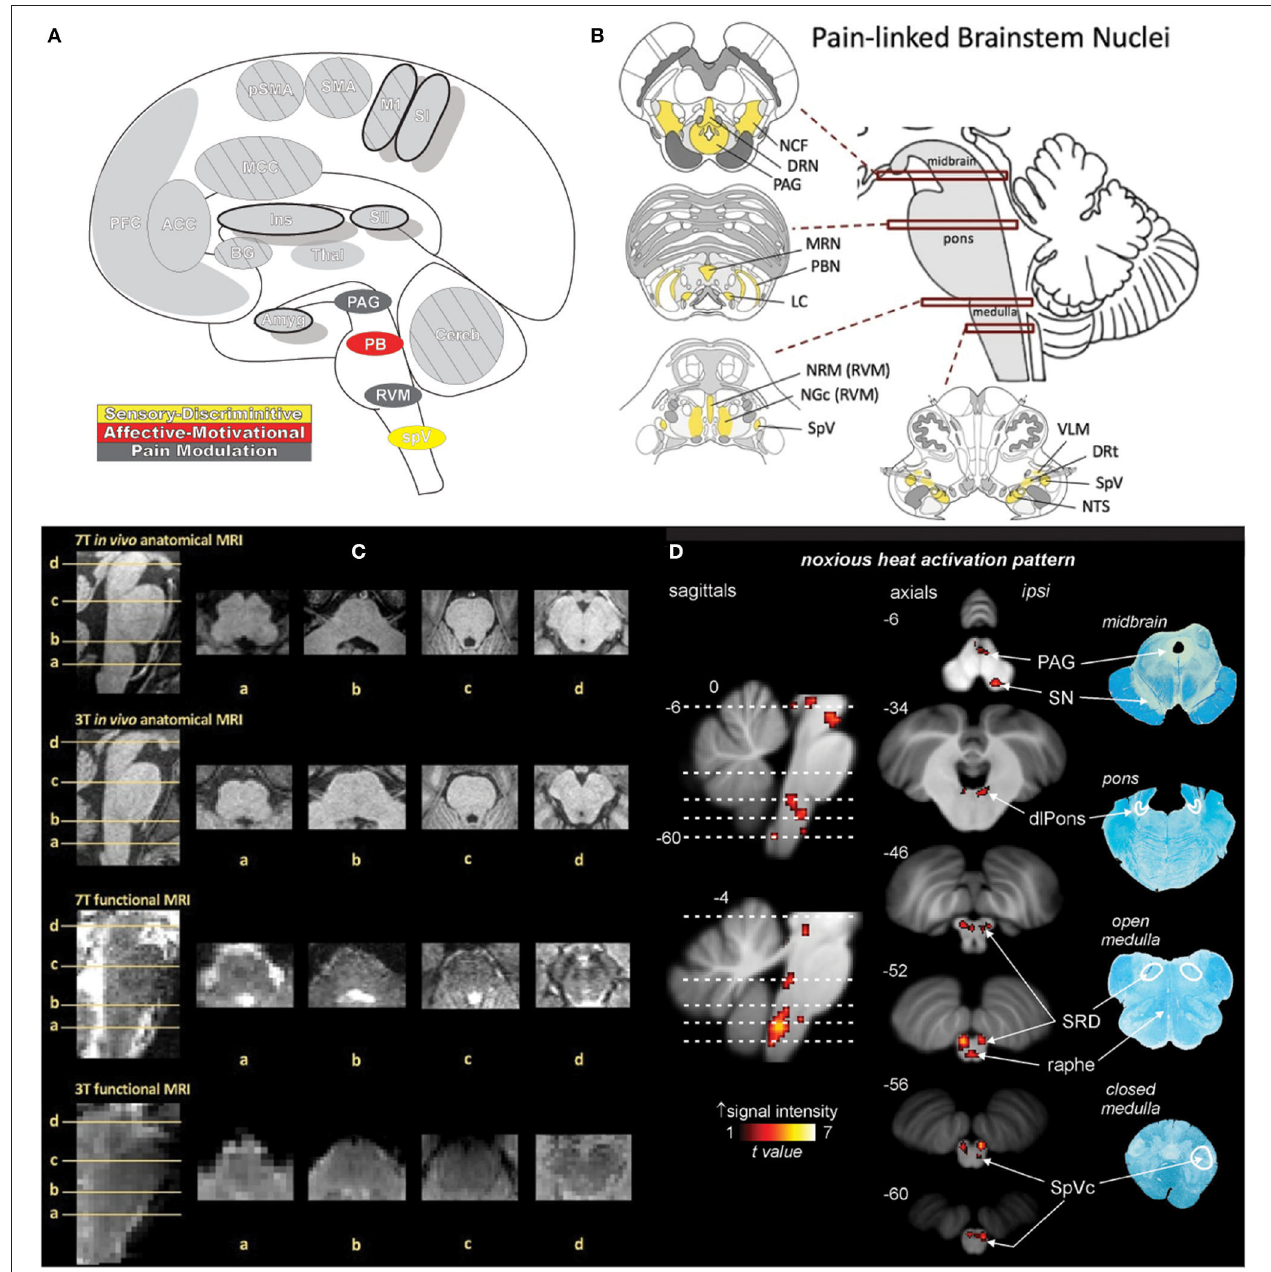
FIGURE 12 | Brainstem. (A) Brain areas active during pain: periaqueductal gray (PAG), parabrachial nuclei (PB), rostral ventromedial medulla (RVM), spinal trigeminal nucleus (SpV) highlighted. (B) Schematic of brainstem nuclei associated with pain processing. Reprinted from PAIN Reports, Vol 4(4), V Napadow, R Sclocco, LA Henderson, Brainstem neuroimaging of nociception and pain circuitries, p e745, Copyright (2019) Napadow et al., under the Creative Commons Attribution License (CC-BY). DOI: https://dx.doi.org/10.1097%2FPR9.0000000000000745. (C) Axial slices containing brainstem nuclei from Figure. 12(B) arranged to compare the spatial resolution and quality of anatomical and functional MRI data at different magnetic field strengths (7 Tesla and 3 Tesla). Advances in imaging techniques and technologies promise to advance neuroimaging investigation of the brainstem as subtle differences in increasingly fine and detailed structures can be appreciated by MRI. Reprinted from PAIN Reports, Vol 4(4), V Napadow, R Sclocco, LA Henderson, Brainstem neuroimaging of nociception and pain circuitries, p e745, Copyright (2019) Napadow et al., under the Creative Commons Attribution License (CC-BY). DOI: https://dx.doi.org/10.1097%2FPR9.0000000000000745. (D) fMRI activations in the medulla, pons, and midbrain in response to brief noxious thermal stimulation, comprising activation of ascending nociceptive pathways and descending pain modulation, highlighting the dense and complex pain circuitry present in the brainstem. Myelin-stained ex-vivo axial sections are displayed to the right of corresponding sagittal and axial MRI slices. Reprinted from NeuroImage, Vol 124(Part A), AM Youssef, VG Macefield, LA Henderson, Pain inhibits pain; human brainstem mechanisms, p54-62, Copyright (2020), with permission from Elsevier. DOI: https://doi.org/10.1016/j.neuroimage.2015.08.060. DRN, dorsal raphe nucleus; DRt, dorsal reticular nucleus; LC, locus coeruleus; MRN, median raphe nucleus; NCF, nucleus cuneiformis; NGc, nucleus gigantocellularis; NRM, nucleus raphe magnus; NTS, nucleus tractus solitarii; PAG, periaqueductal gray; PBN, parabrachial nucleus; RVM, rostral ventromedial medulla; SpV, spinal trigeminal nucleus; VLM, ventrolateral medulla; SpVc, spinal trigeminal nucleus caudalis; SRD, subnucleus reticularis dorsalis; dlPons, dorsolateral pons; PAG, periaqueductal gray; SN, substantia nigra. Frontiers in Medicine |